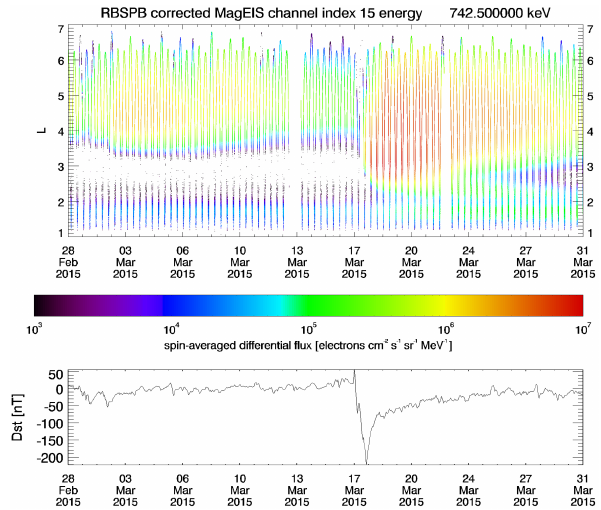
Figure 5. Electron fluxes observed by EPT/PROBA-V in Channel 6 (2.4–8MeV) as a function of L between 28 February and 13 April 2015.